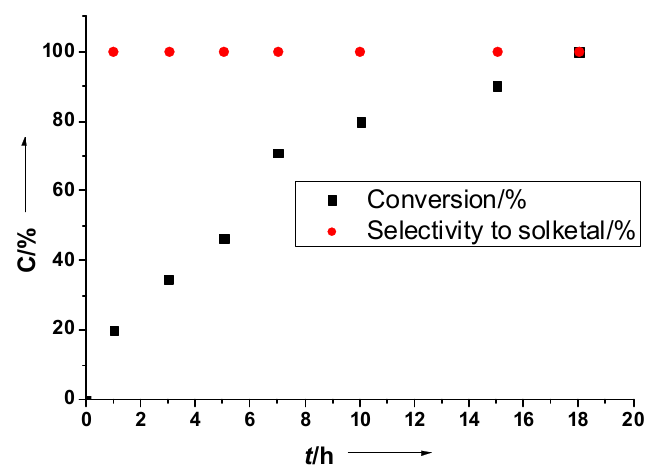
Figure 1. Glycidol conversion to solketal using Nafion NR50 (reaction conditions: glycidol/acetone moles ratio 1:43, catalyst loading 20 wt %,